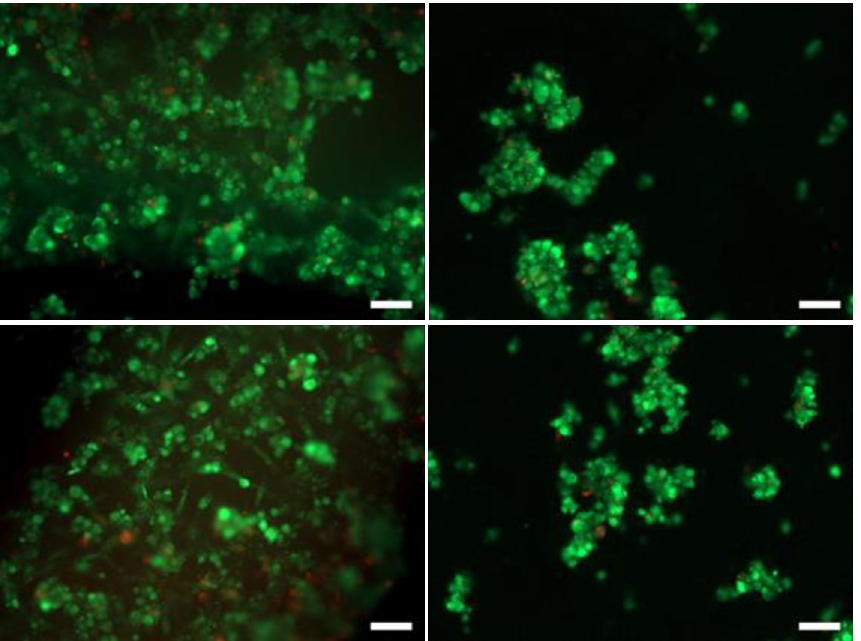
Fig 8. Epi-fluorescent microscopy images of MRC-5 cells on carbon electrodes pre-treated with poly-D-lysine (scale bar 100 μ m). Reactors were inoculated with 200 000 cells. After 4 hours of incubation, electrodes were stained with Syto9 1 (green, total cells) and IP staining (red, damaged cells). Left column: Plastic strip between the working and auxiliary electrodes; right column: On the working